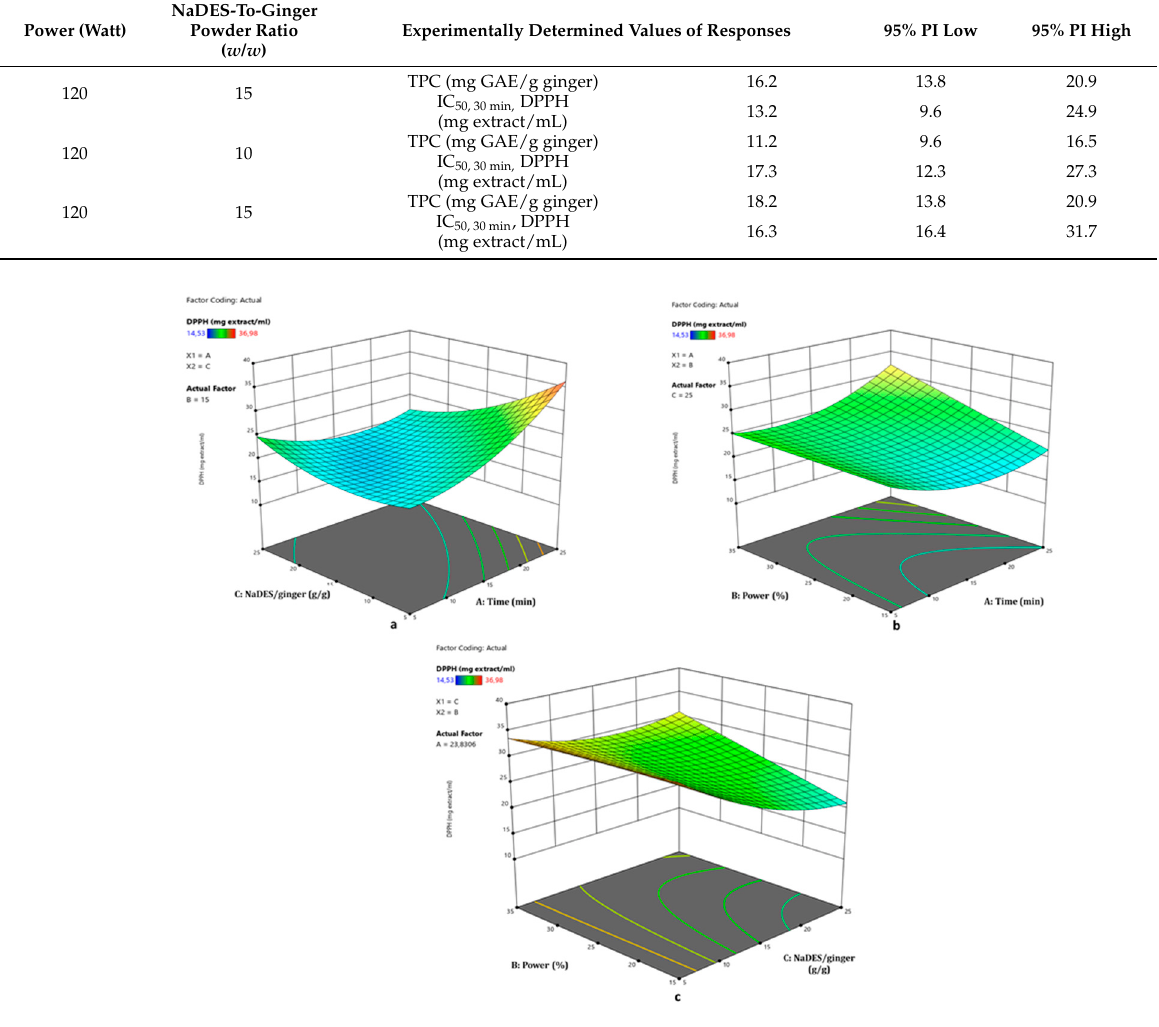
Figure 5. RSM plots for DPPH response showing the correlation between DPPH and the factors: ( a ) time and NaDES-to-dry ginger ratio, ( b ) time and ultrasound power ( c ) ultrasound power and NaDES-to-dry ginger